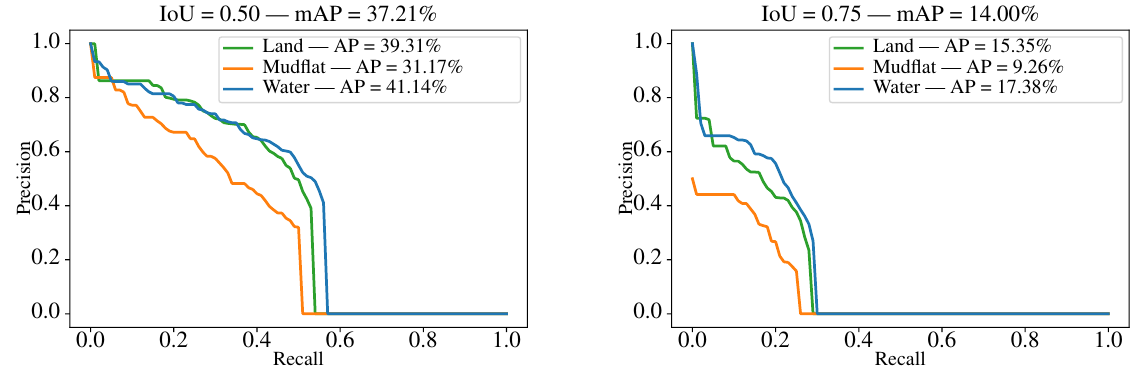
Figure 7. Precision-Recall curves for Faster RCNN and two IoU